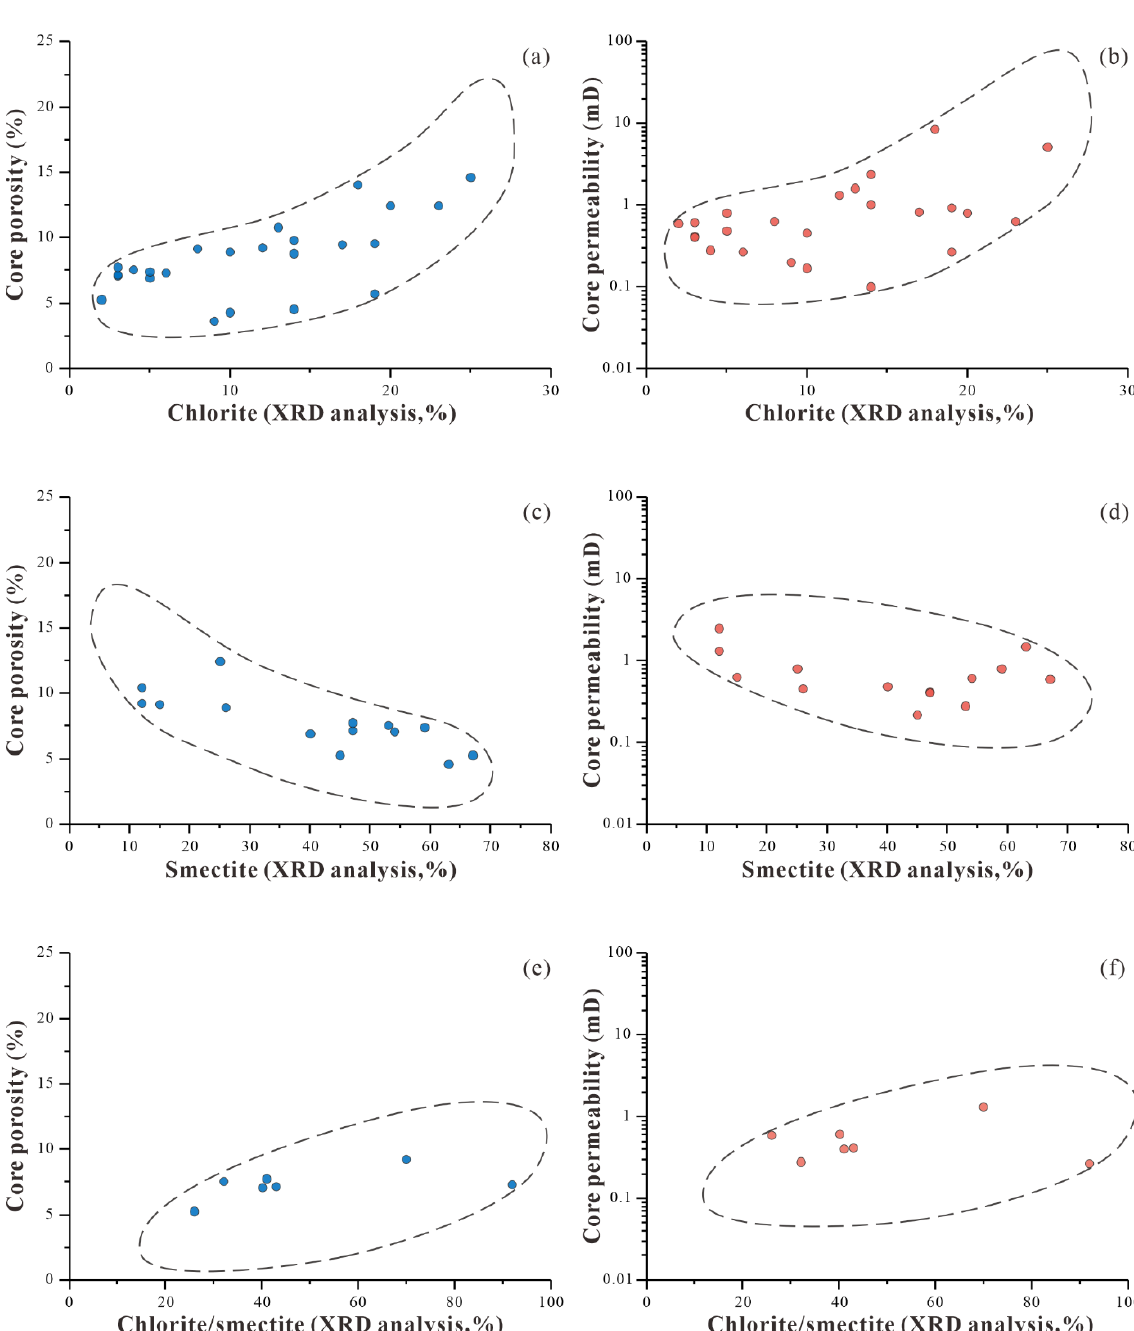
Figure 18. Relationship between different clay minerals and the reservoir physical properties: ( a ) Chlorite and porosity; ( b ) Chlorite and permeability; ( c ) Smectite and porosity; ( d ) Smectite and permeability; ( e ) Chlorite/smectite mixed layer and porosity; ( f ) Chlorite/smectite mixed layer and permeability.